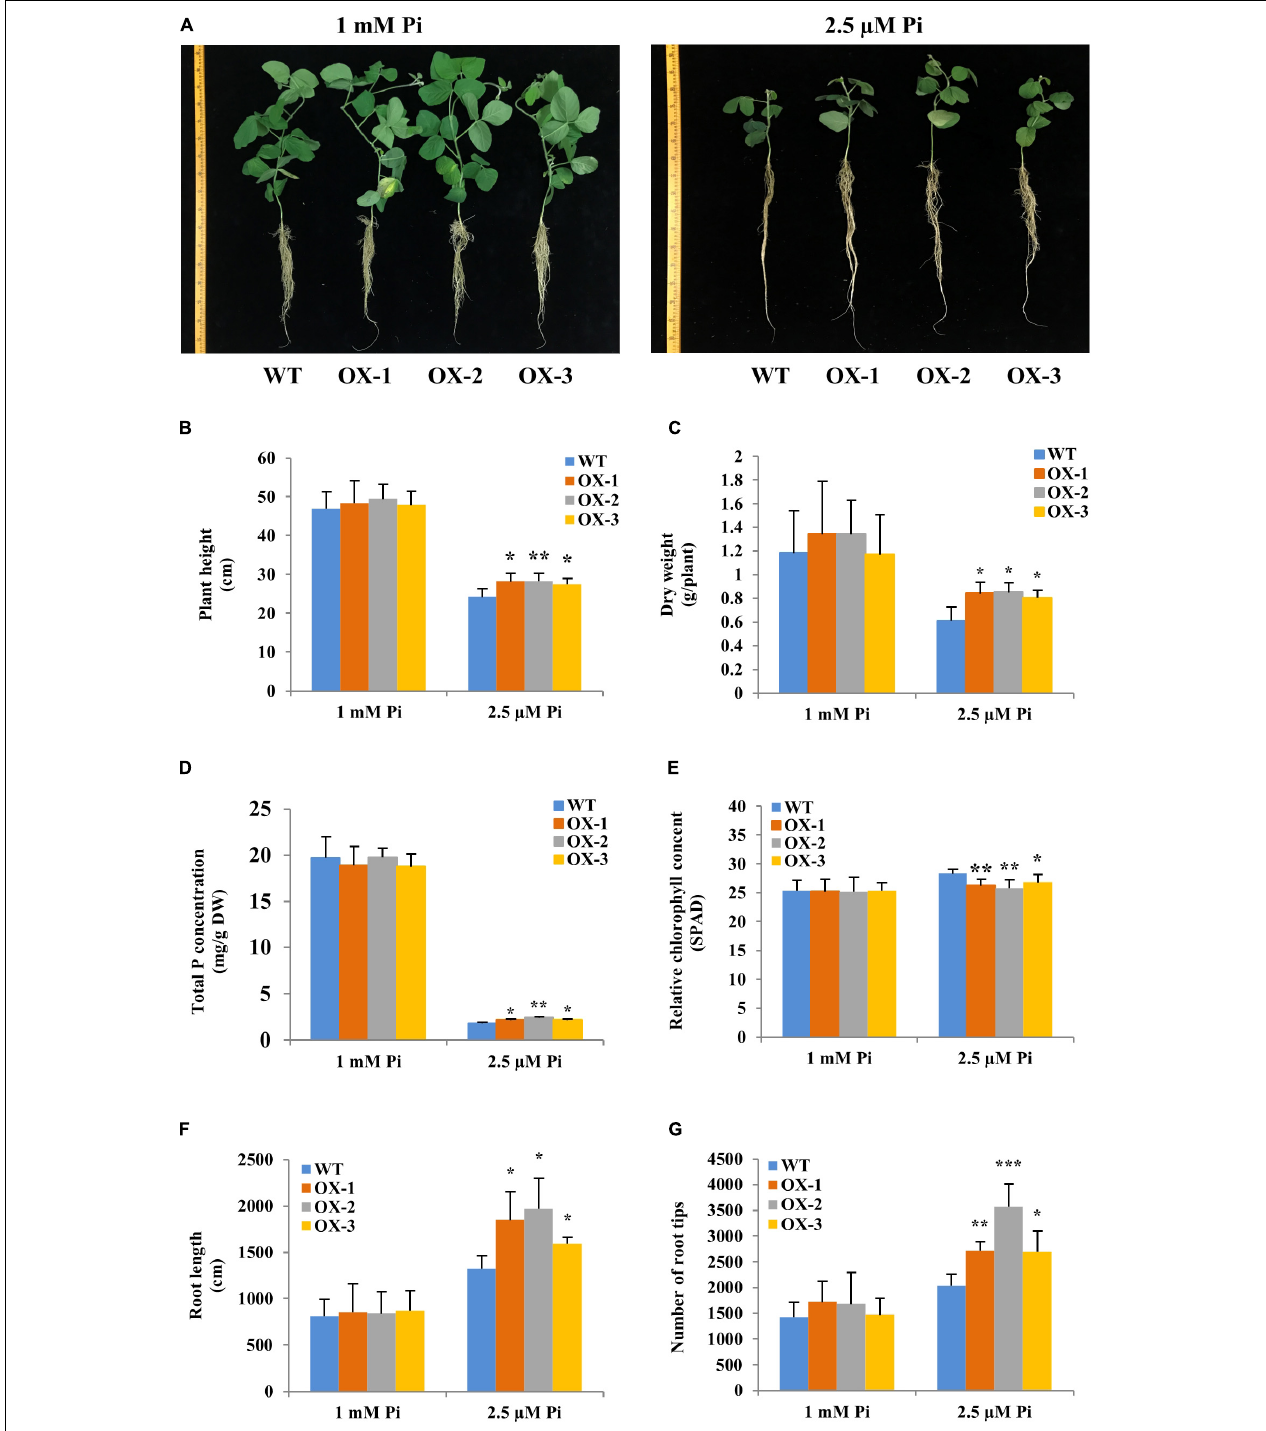
FIGURE 4 | Overexpression of Gm6PGDH1 enhances tolerance to Pi starvation in transgenic soybean. Five-day-old seedlings (removal of cotyledons) were exposed to nutrient solutions containing two levels of Pi, 1 mM Pi (Pi-sufficient), or 2.5 µ M Pi (Pi-deficient) for 30 days. (A) Phenotypes of wild type (WT) and Gm6PGDH1 -overexpressing lines (OX-1, OX-2, and OX-3) in response to two levels of Pi treatment. Scale unit: cm. (B–G) Plant height, fresh weight, total P concentrations, chlorophyll content, the total root length, and the number of root tips were recorded at the end of the treatment period. Data are means of three replicates with SD. Asterisks show that the values are significantly different between the transgenic lines and the WT at the same time point (Student’s t -test, * P < 0.05, ** P < 0.01, *** P < 0.001).